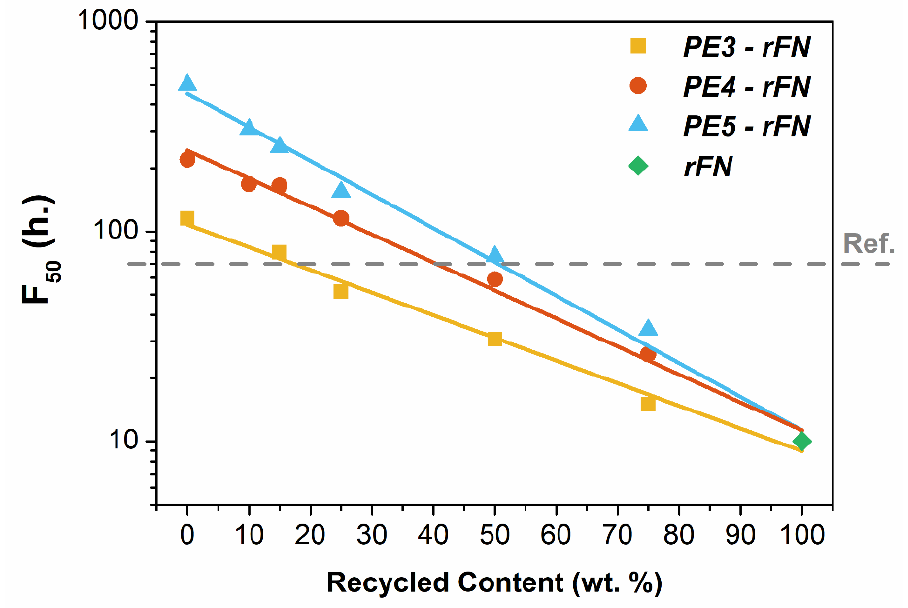
Figure 7 . ESCR F 50 values (h) vs. recycled content for all blends. Figure 7. ESCR F 50 values (h) vs. recycled content for all